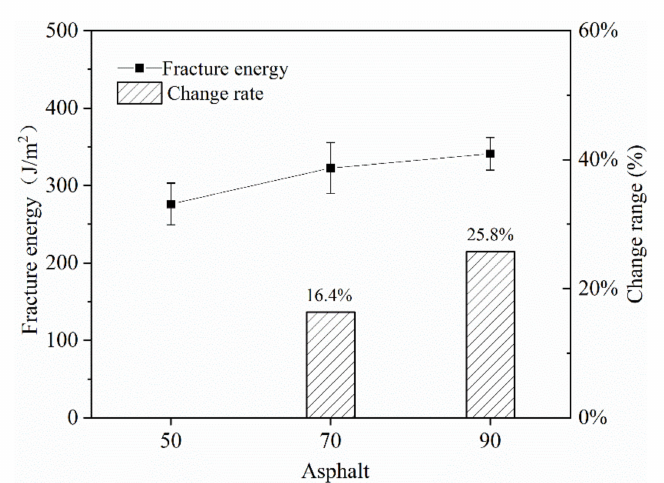
Figure 9. The e ff ect of di ff erent grades of asphalt on the fracture energy of the